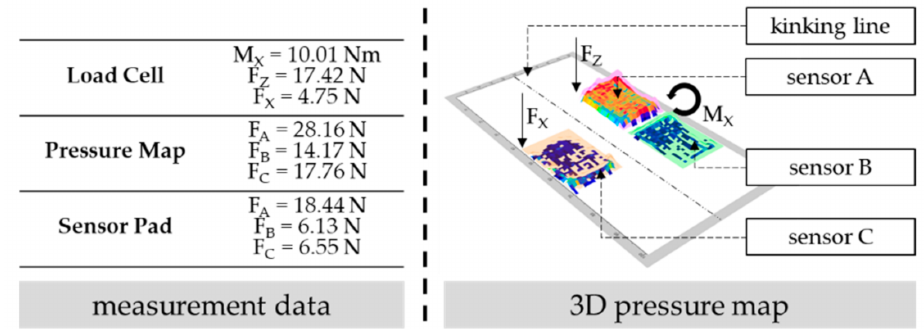
Figure 7. Comparison of the measured or calculated forces/torques at the same point of time of the respective measurement equipment ( left ) as well as a planar 3D-illustrated pressure map by the software from Xsensor ( right